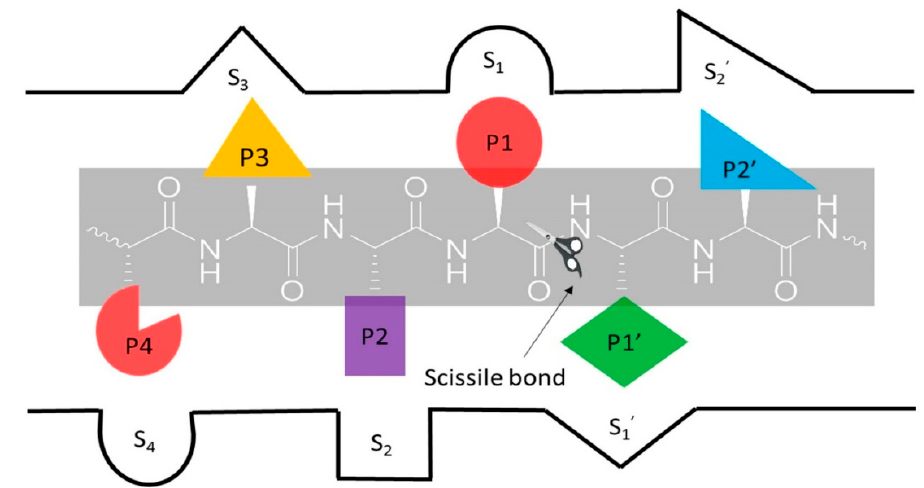
Figure 1. Proteolysis of the scissile bond between P 1 and P 1 ’. Standard nomenclature P 1 … P n and P 1 ’… P n ’ for amino acid residues of the substrates. S 1 ... S n and S 1 ’… S n ’ are the corresponding binding sites on the enzyme (per Berger and Schechter nomenclature (3)).